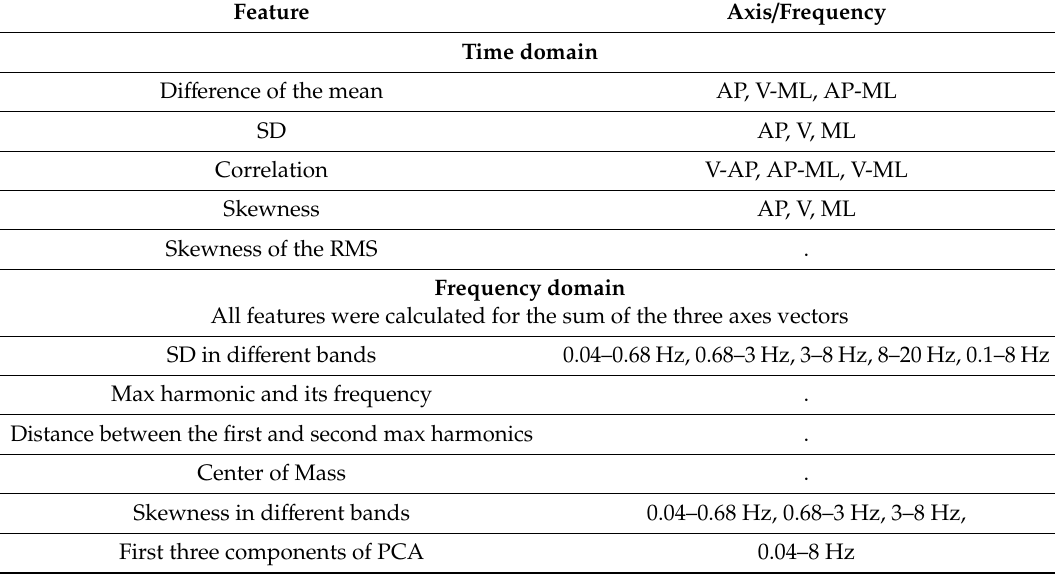
Table 1. The feature set according to Sam à et al. [23]. Features were calculated from the back